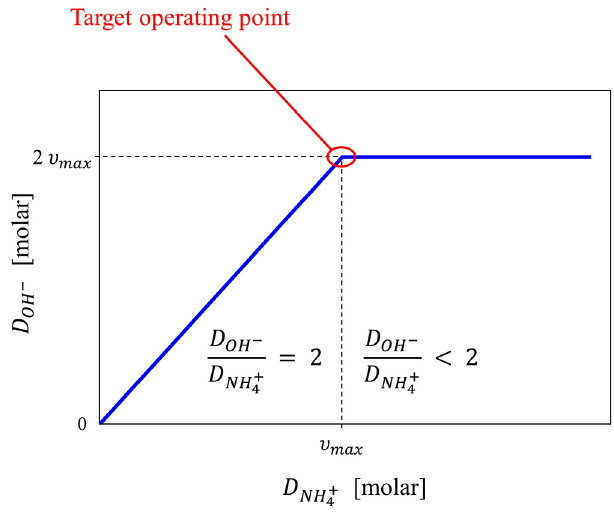
Figure 4. Plot of the hydroxide dosing rates ( D OH − ) required for pH control as a function of the ammonium dosing rates . At lower ammonium dosing rates, which are below υ max , the hydroxide dosing rates are double the ammonium dosing rates (see Equations (1) and (2)) since all the ammonium dosed is consumed. When the ammonium dosing rates are higher than υ max , the hydroxide dosing rates remain constant at 2 υ max regardless of D NH + 4